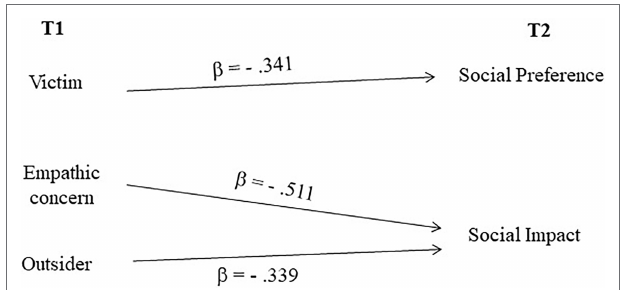
FIGURE 1 | Significant predictors at t1 of participant roles at t2 (regression analyses).